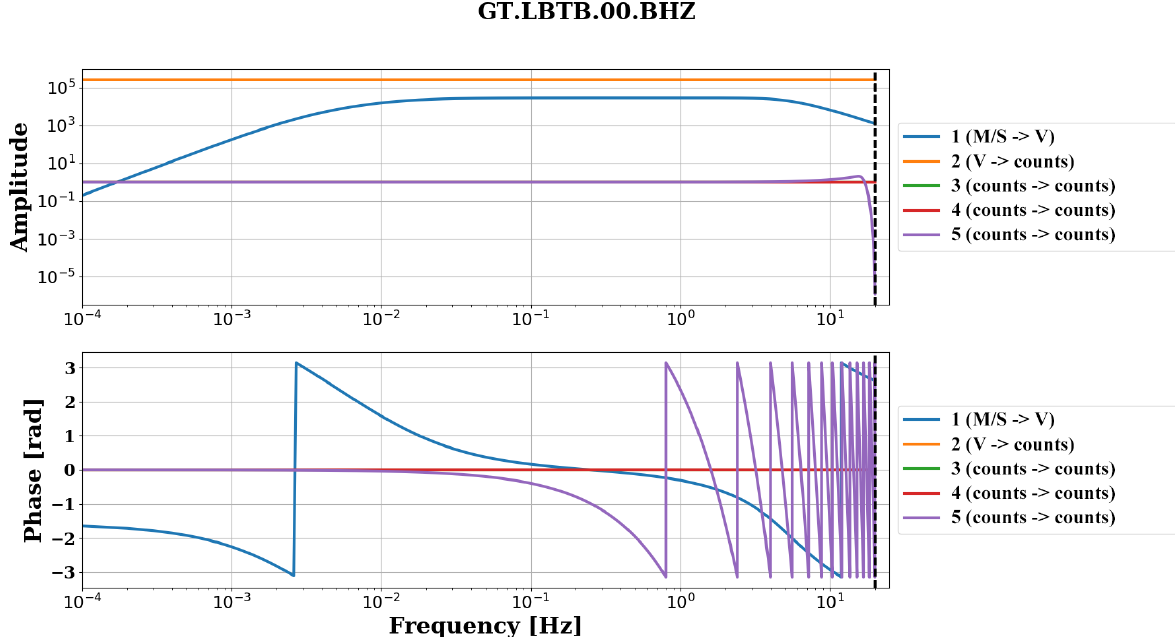
Figure 8. obspyDMT --datapath /path/to/STXML.GT.LBTB.00.BHZ --plot_stationxml --plotxml_min_freq 0.0001 --plotxml_allstages Transfer function spectra (amplitude and phase) of each stage in the StationXML file of a Geotech KS-54000 borehole seismometer (GT.LBTB) in Botswana. In the phase response, two stages (1 and 5) have non-zero values. Both stages contribute to the phase spectrum of the complete instrument response (“full-resp”) of Fig. 7. However, the effects of Stage 5 on amplitude and phase spectra are not considered in PAZ